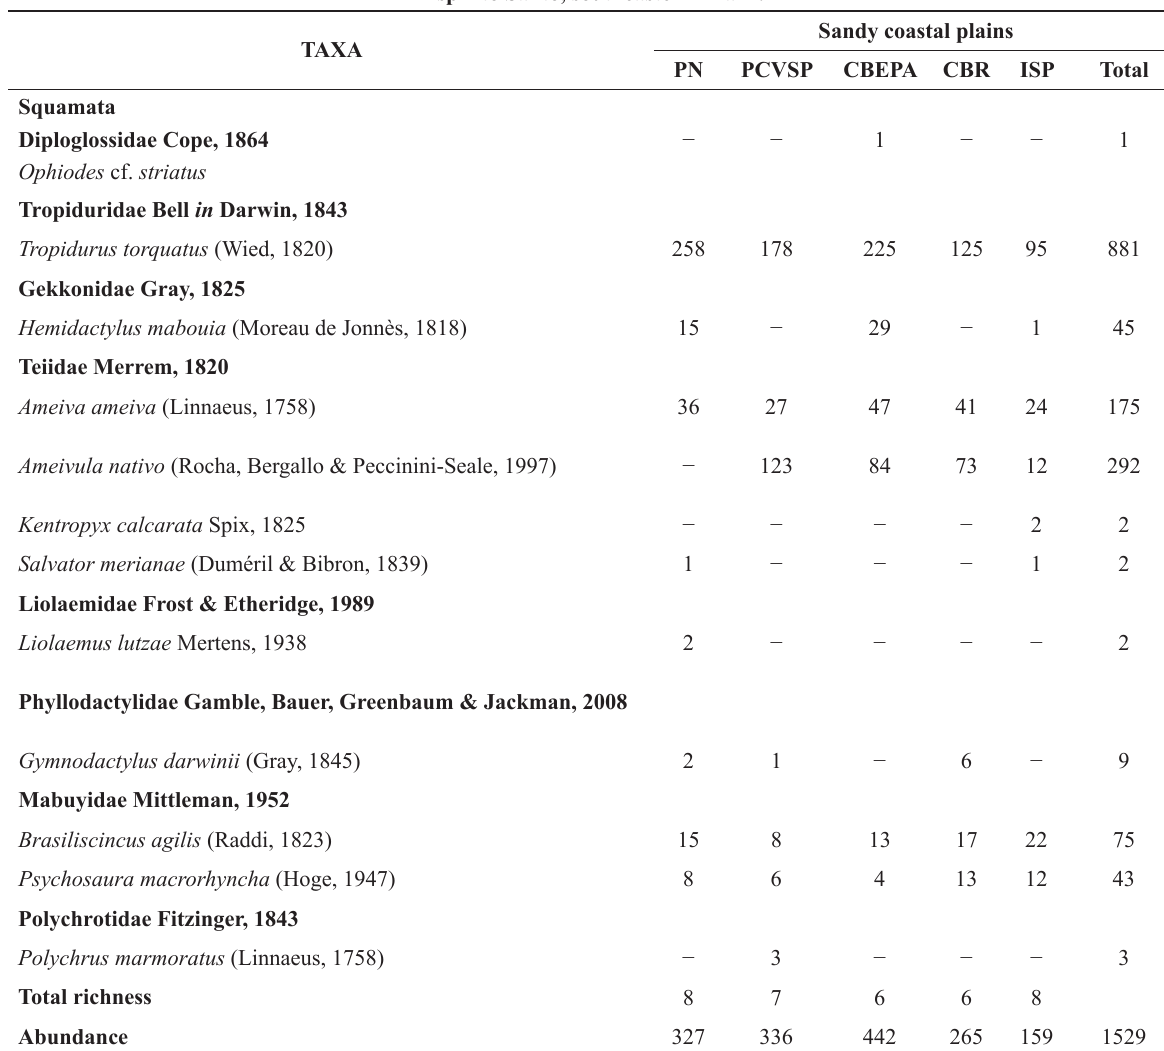
Species and their specific abundances of lizards sampled in five sandy coastal plains remnants on the coast of the state